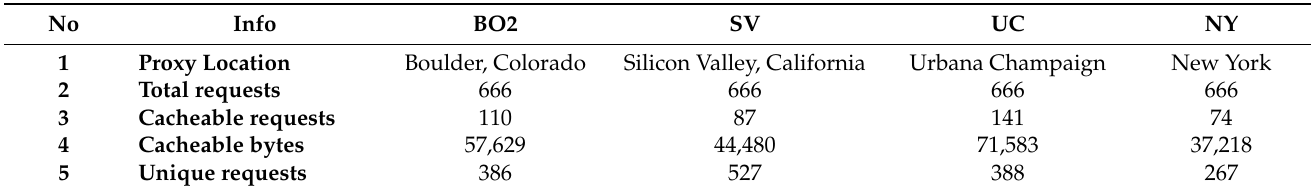
Table 1. Description of the four datasets used in this